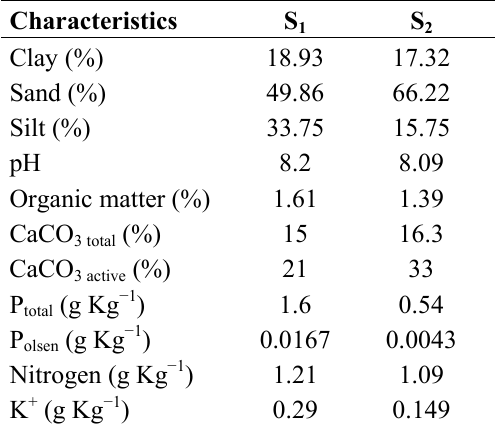
Table 2. Chemical and physical properties of the soils used in the